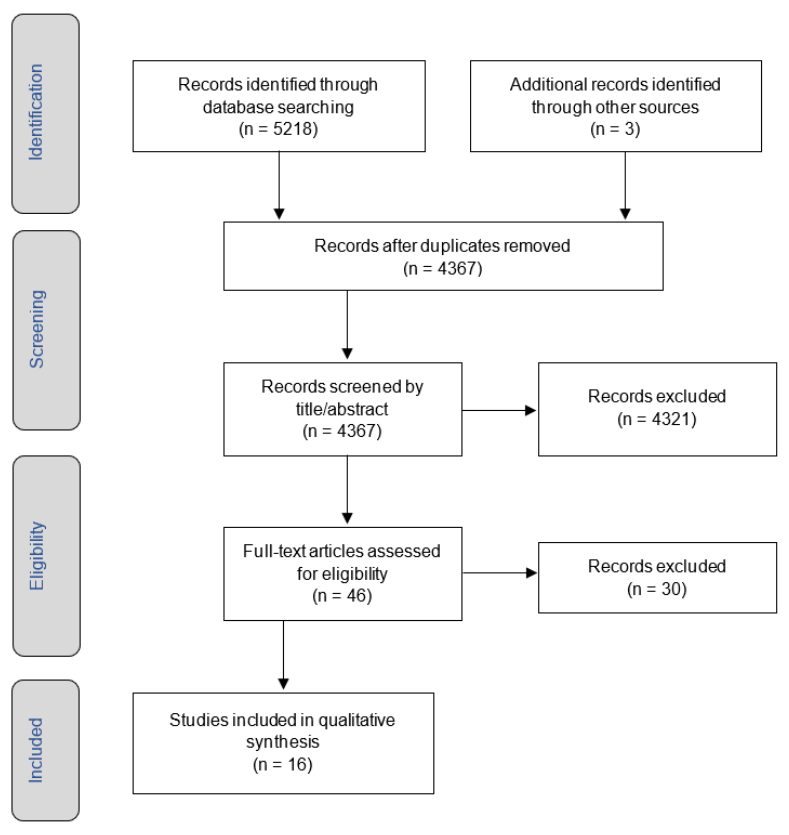
Figure 1. PRISMA search and study selection process [47].